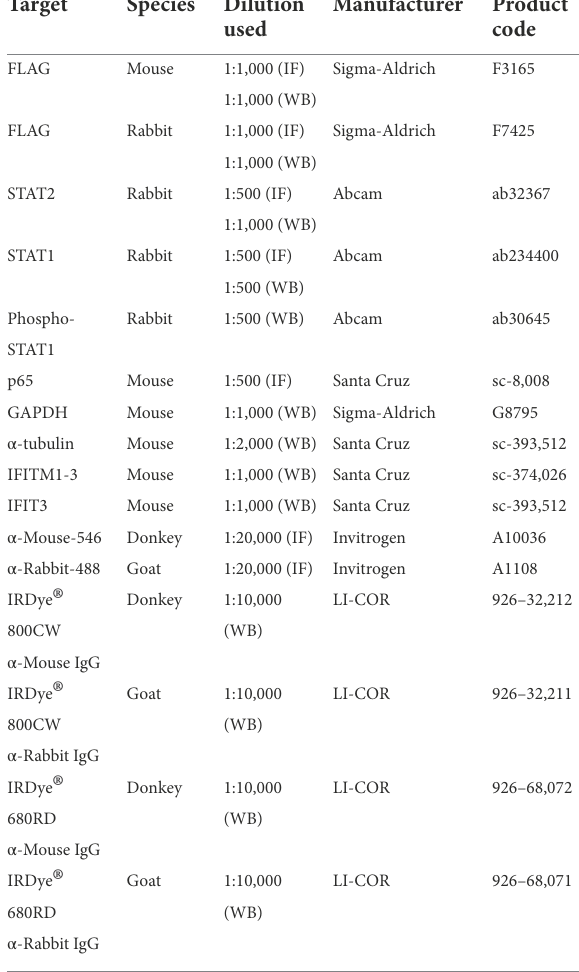
TABLE 1 Antibodies used in this